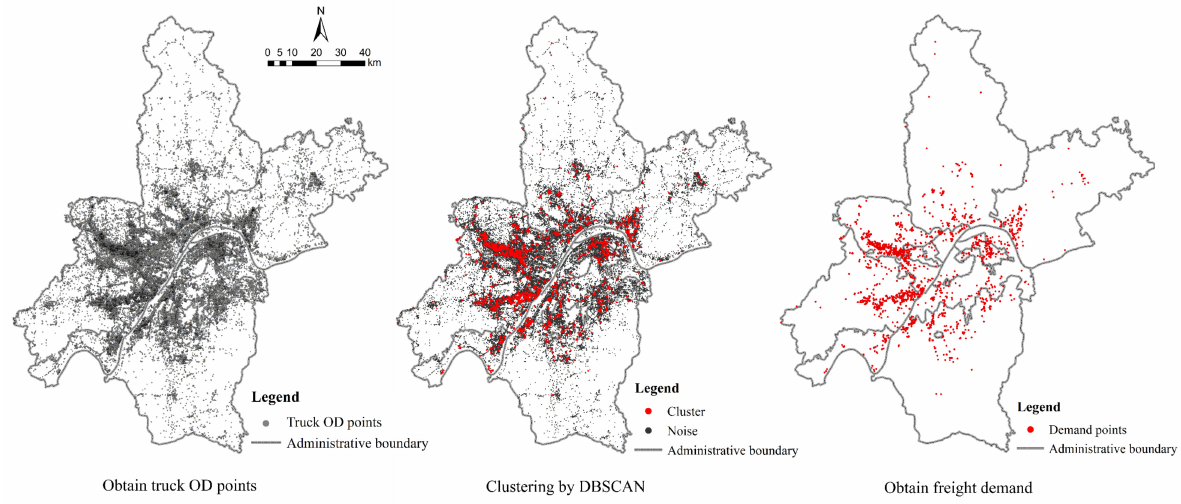
Figure 4. The process of identifying demand